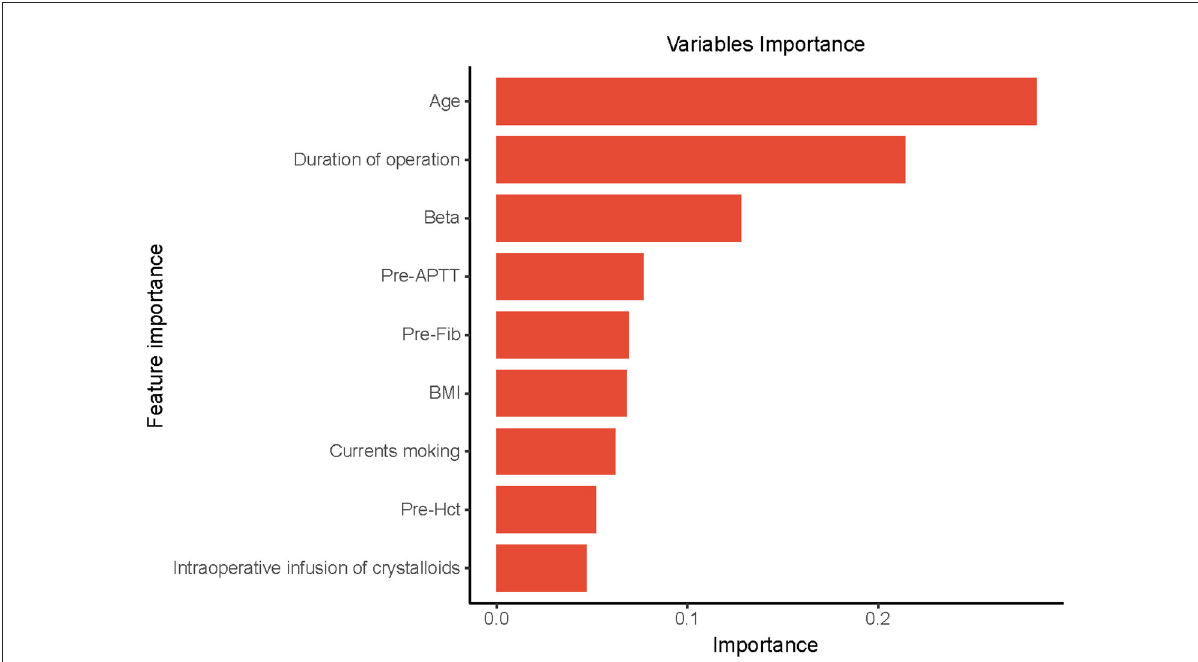
FIGURE5 The importance of the variables in the Random Forest (RF) model is in decreasing order as follows: Age, Duration of operation, Beta, Pre-APTT, Pre-Fib, BMI, Current smoking, Pre-Hct, intraoperative infusion of crystalloids. Pre-APTT, pre-operative activated partial thromboplastin time; Pre-Fib, pre-operative fibrinogen; BMI, body mass index; Pre-Hct, pre-operative